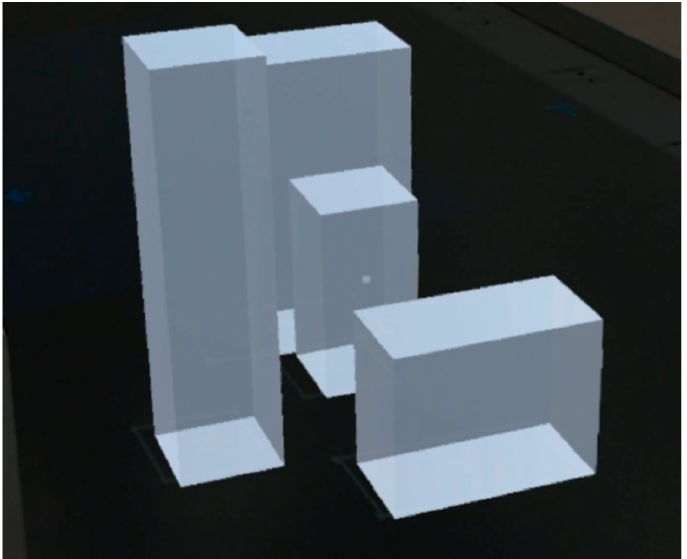
Figure 9. A simple scene of self-transparent rectangular prisms with 50% opacity, as viewed from the